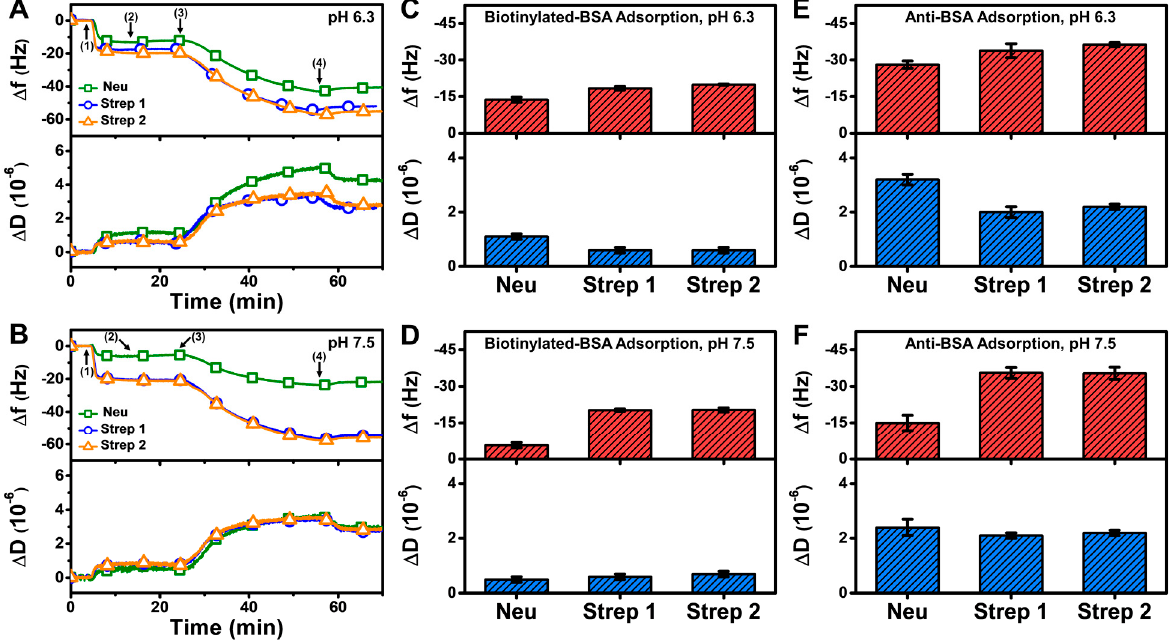
Figure 8. QCM-D measurement responses for biotinylated BSA and subsequent anti-BSA binding to Neu- and Strep-functionalized SLB platforms. Time-resolved QCM-D frequency ( ∆ f, upper panel) and energy dissipation ( ∆ D, lower panel) for biotinylated BSA and anti-BSA adsorption onto Neu- and Strep-functionalized SLB platforms fabricated at ( A ) pH 6.3 and ( B ) pH 7.5. The initial baselines correspond to the shifts for a Neu- or Strep-functionalized SLB post-washing with pH 7.5 buffer and biotinylated BSA was added starting at t = 5 min (arrow 1), followed by washing with pH 7.5 buffer at t = 15 min (arrow 2), anti-BSA addition at t = 25 min (arrow 3), and washing with pH 7.5 buffer at t = 55 min (arrow 4). Final ∆ f (upper panel) and ∆ D (lower panel) shifts for biotinylated BSA adsorption onto Neu- and Strep-functionalized SLB platforms that had been fabricated at ( C ) pH 6.3 and ( D ) pH 7.5, and corresponding data for subsequent anti-BSA adsorption in the ( E ) pH 6.3 and ( F ) pH 7.5 cases. All data are reported as mean ± standard deviation from n = 3